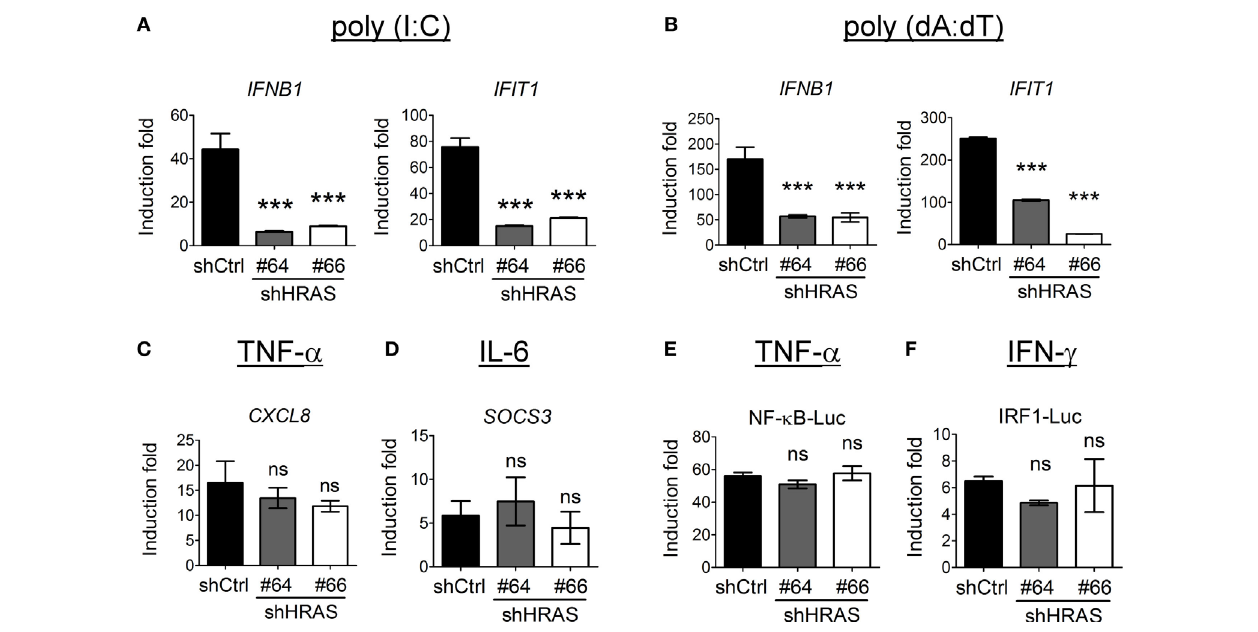
FigUre 7 | H-Ras regulates melanoma differentiation-associated gene 5 (MDA5)- and STING-mediated type I interferon responses but does not influence tumor necrosis factor (TNF)- α , IL-6, or IFN- γ signaling. HEK293T cells were treated with control shRNA (shCtrl) or shRNAs targeting HRAS (#64 or #66). (a) The cells were first transfected with the MDA5-expressing plasmid for 24 h, then transfected with poly(I:C) (1 µg/ml) for 8 h to induce MDA5 signaling, or (B) they were transfected with poly(dA:dT) (20 µg/ml) for 8 h to induce STING signaling. Gene transcription of IFNB and IFIT1 was analyzed by RT-qPCR. (c,D) The shRNA-treated HEK293T cells were treated with TNF- α (40 ng/ml) (c) , or with IL-6 (40 ng/ml) (D) , for 18 h. The downstream gene transcription of CXCL8 and SOCS3 , respectively was analyzed by RT-qPCR. (e,F) The shRNA-treated HEK293T cells were transfected with pNF- κ B-Luc reporter plasmid (e) or pIRF1-Luc reporter plasmid (F) , together with the pTK-RL plasmid. In all groups, the total amounts of transfected DNA were adjusted to the same using the control vector DNA. Cells were treated with TNF- α (40 ng/ml) (e) , or with IFN- γ (500 ng/ml) at 24 h post-DNA transfection, and luciferase activity was measured at 18 h post cytokine treatment. The results of induction fold were obtained from three independent experiments and presented as the mean ± SD. *** P < 0.001 between the indicated groups and the control shRNA-treated group (one-way ANOVA followed by Dunnett’s post hoc analysis). ns, not